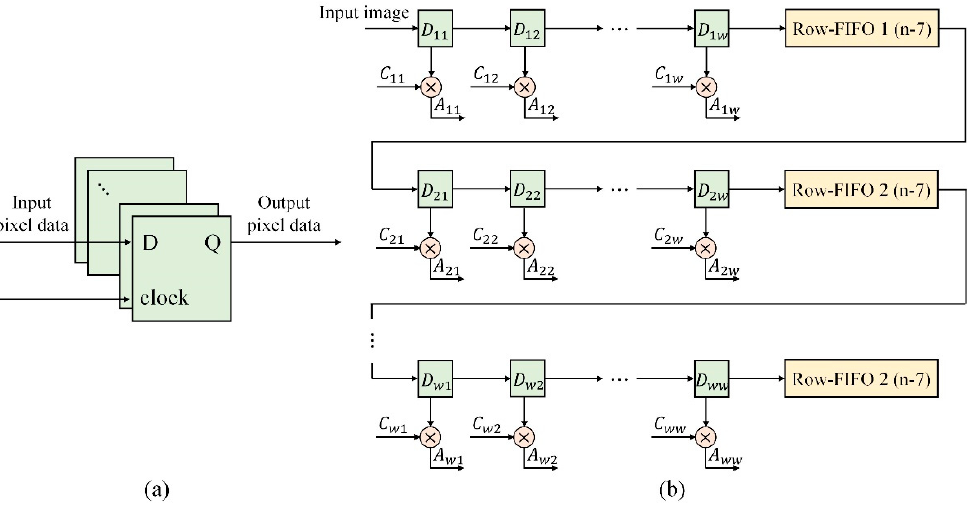
Figure 4. Architecture of filter implemented on an FPGA: ( a ) illustration of the pixel data flip-flops, ( b ) architecture of filter implemented on an FPGA the green boxes represent the pixel data flip-flops.